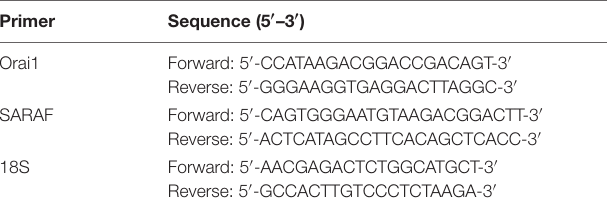
TABLE 1 | Forward and reverse primers used to quantify the mRNA expression of Orai1, SARAF, and 18S.